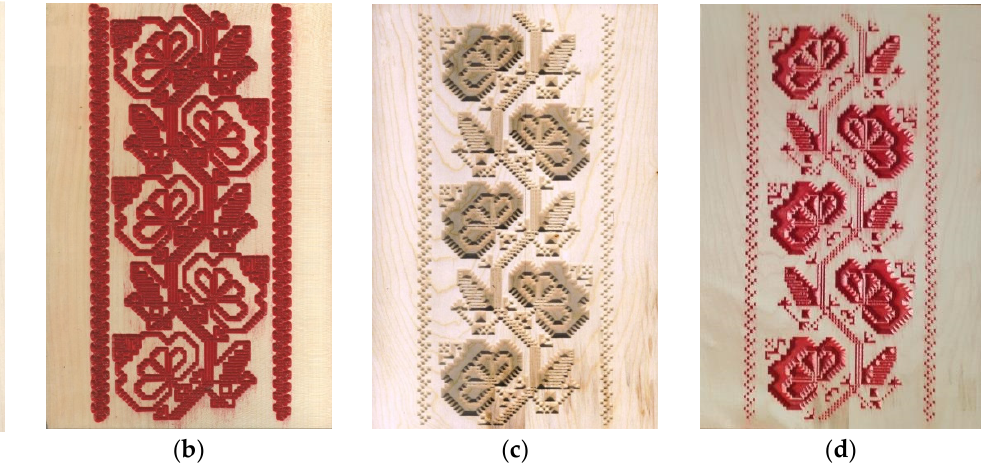
( d ) Figure 11. Coloring of the wood surface: ( a ) CNC engraved motif on colored maple wood; ( b ) lac- quered panel ( a ); ( c ) CNC V-carved motif on colored maple wood; ( d ) lacquered panel ( c ).